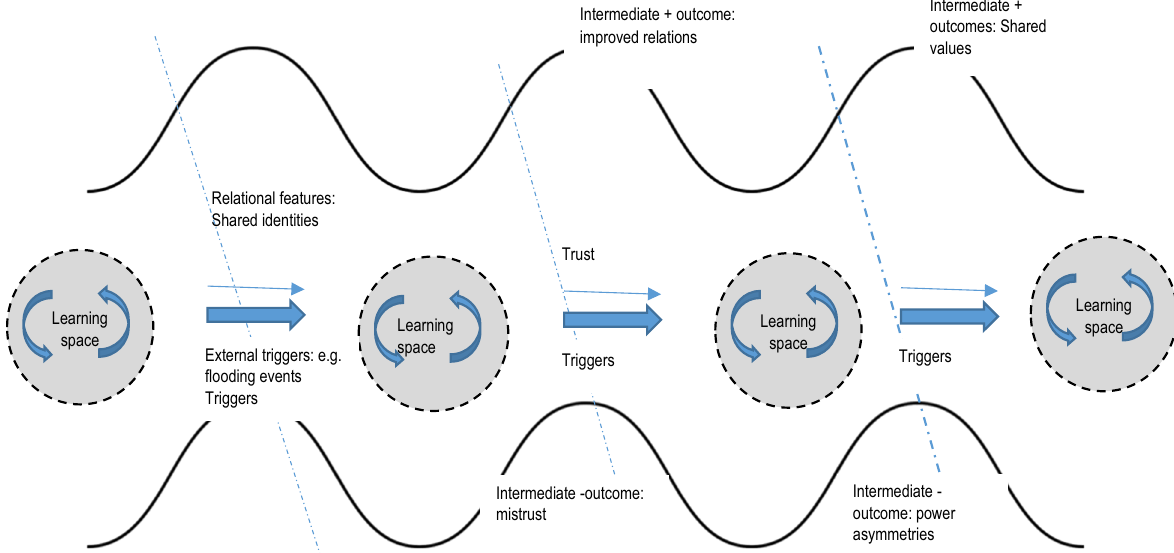
Fig. 2 Learning space and emergence of relational features. Shows how actors continuous develop interaction, deliberation, and reframing (learning space) triggered by relational features such as trust and shared identities that result in intermediate (positive and negative) outcomes at different stages